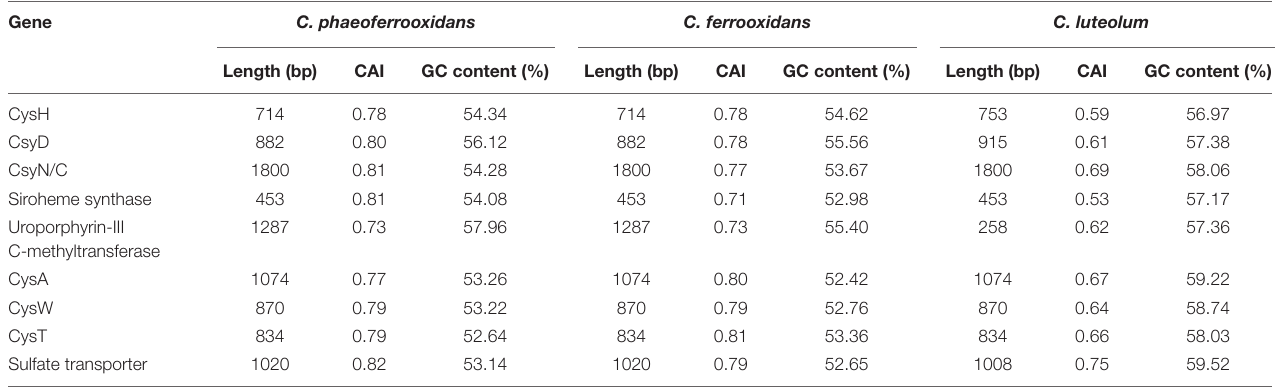
TABLE 3 | Gene length (bp), CAI, and GC content (%) for each of the genes in the ASR cassette. Gene